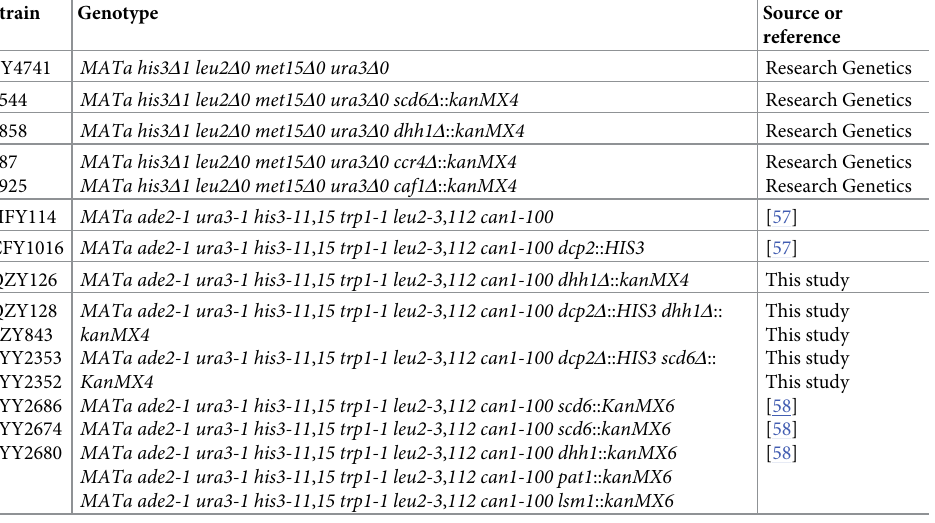
Table 2. Yeast strains used in this